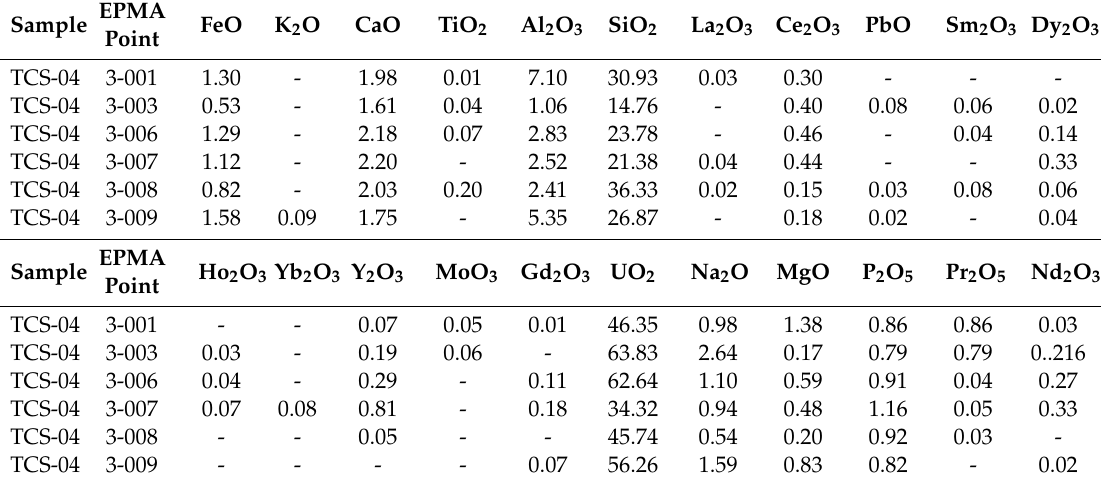
Table 6. Composition of pitchblende (%) analyzed by